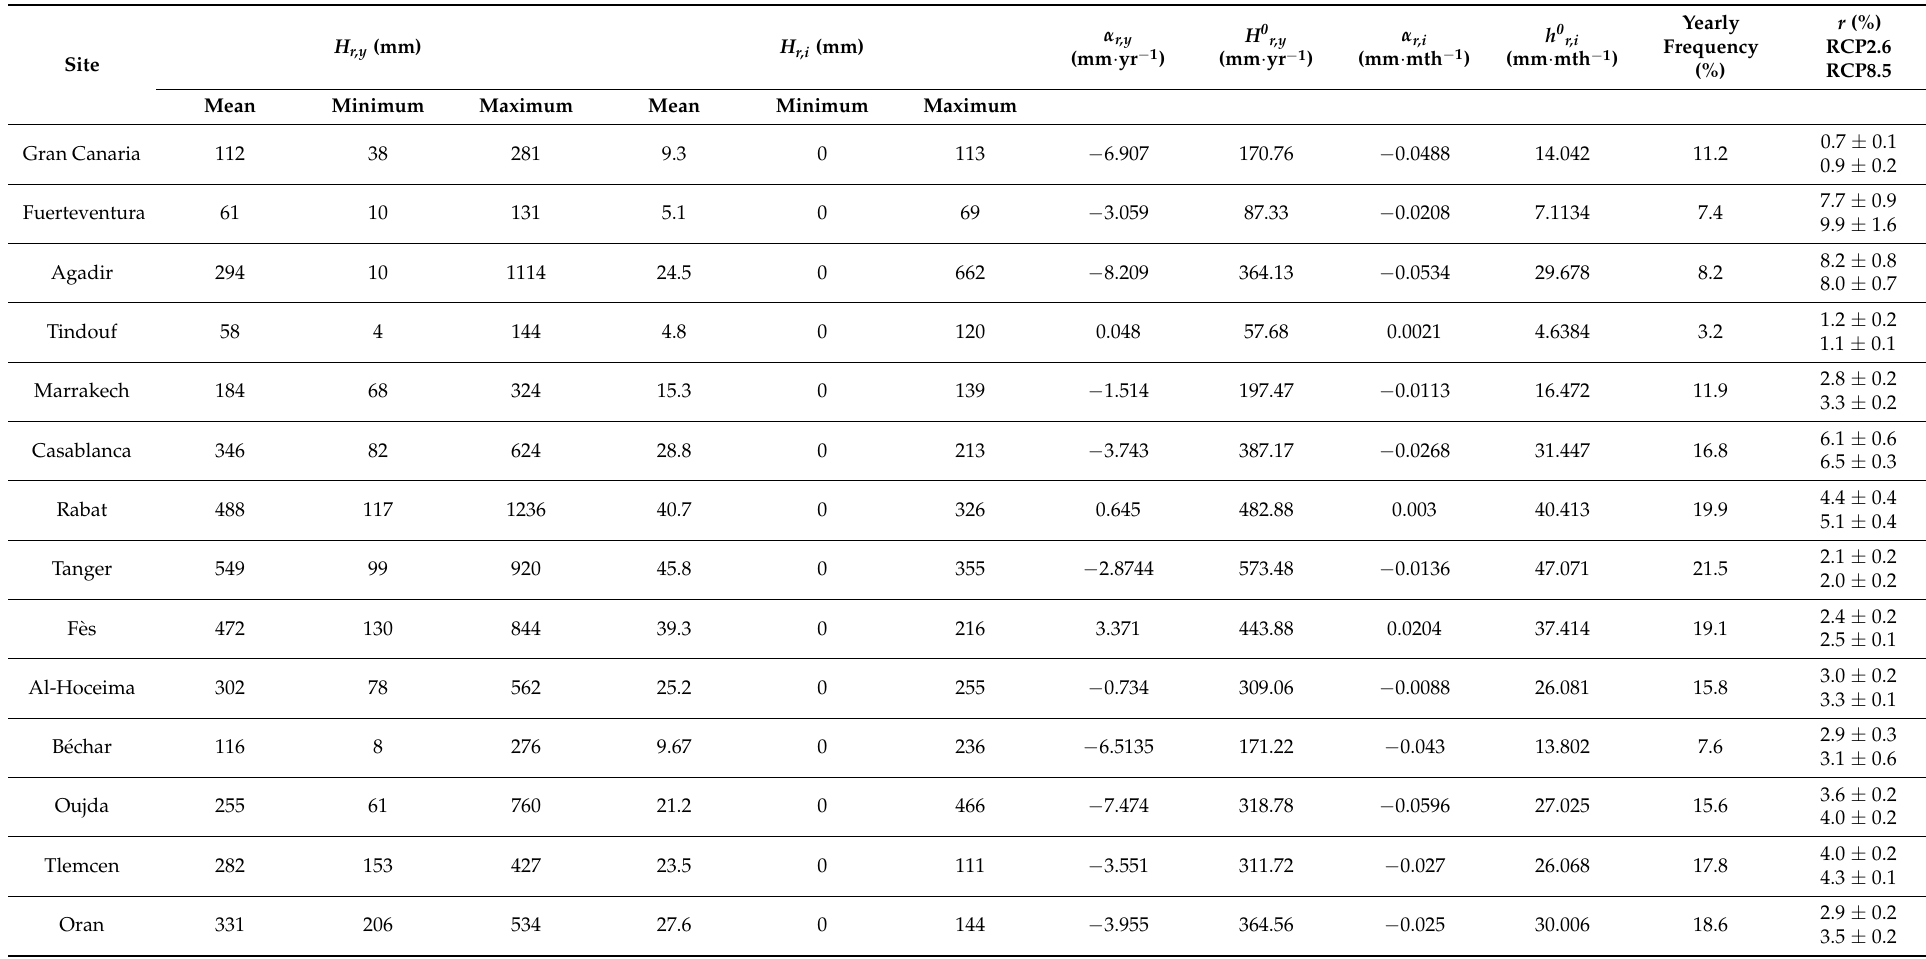
Table 4. Yearly ( H r,y ) and monthly ( H r,i = H r,y /12) rainfall values from meteorological data. Mean (arithmetic), minimum and maximum values are reported for the 16 years period (2005–2020). The evolution of the yearly and monthly mean values is fitted to Equation (14) with α r , y and H 0 r , y (yearly means) and α r , i and H 0 (monthly means) as free parameters. Red values correspond to a decrease, blue values to an increase. r is the ratio between the yearly cumulative dew and rainfall volumes averaged over the period 2005–2020 (Equation